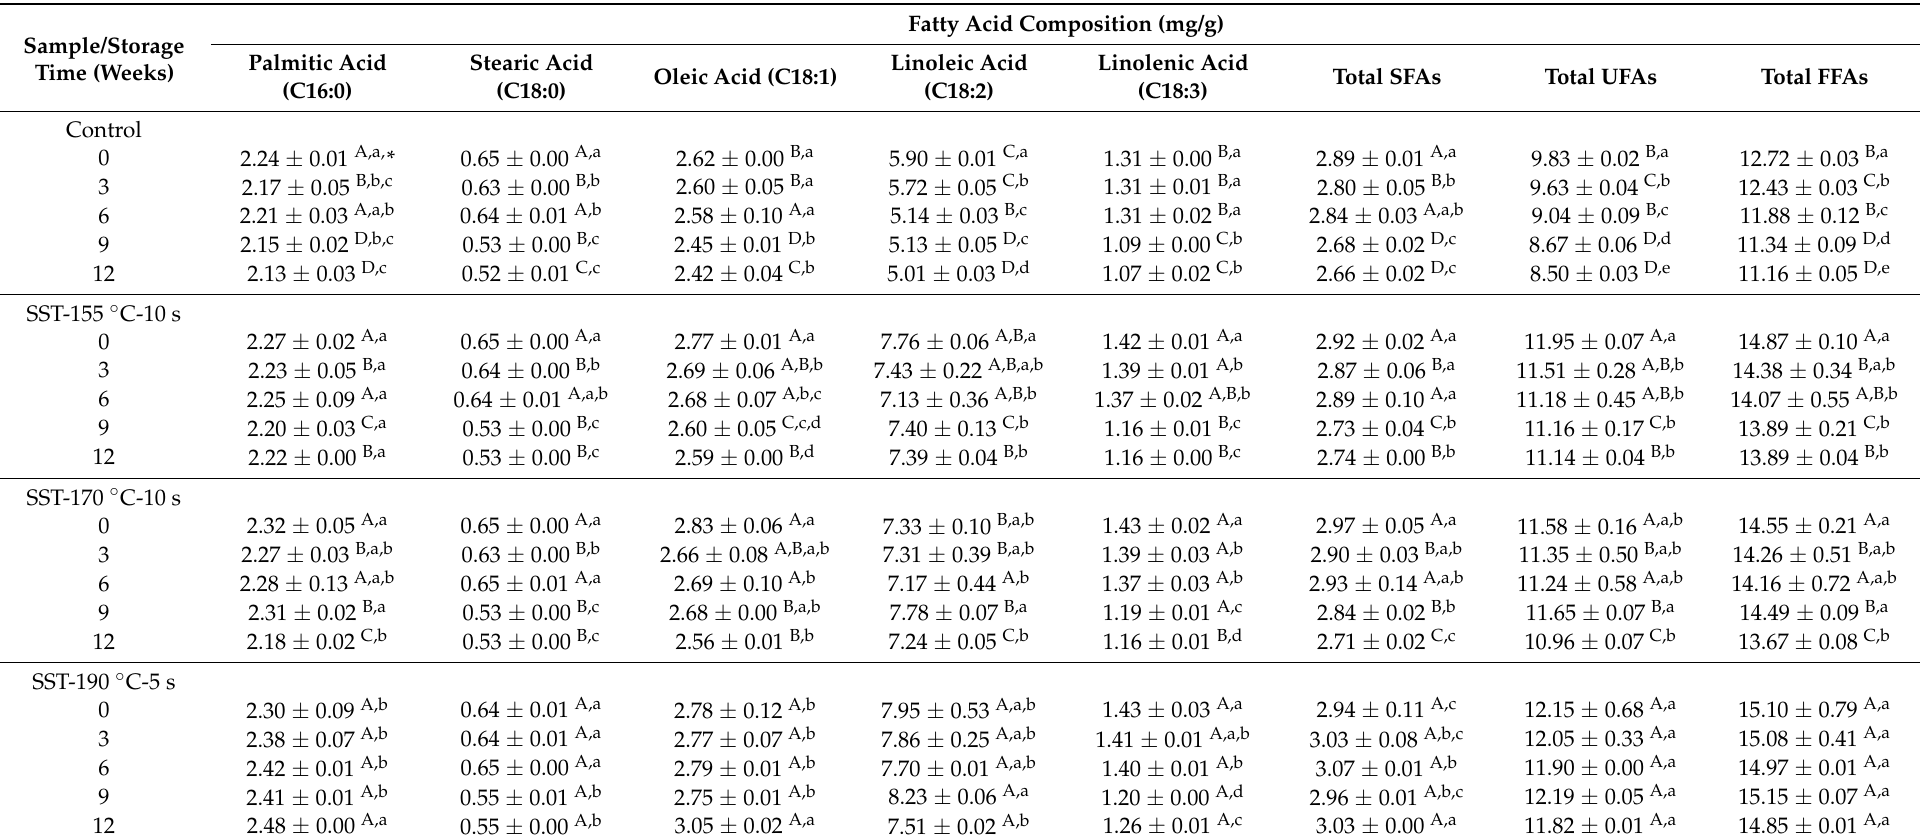
* Superscript uppercase and lowercase letters indicate significant differences within rows and columns at p < 0.05, respectively. SST-superheated steam treatment, SFAs: saturated fatty acids, UFAs: unsaturated fatty acids, FFAs: free fatty